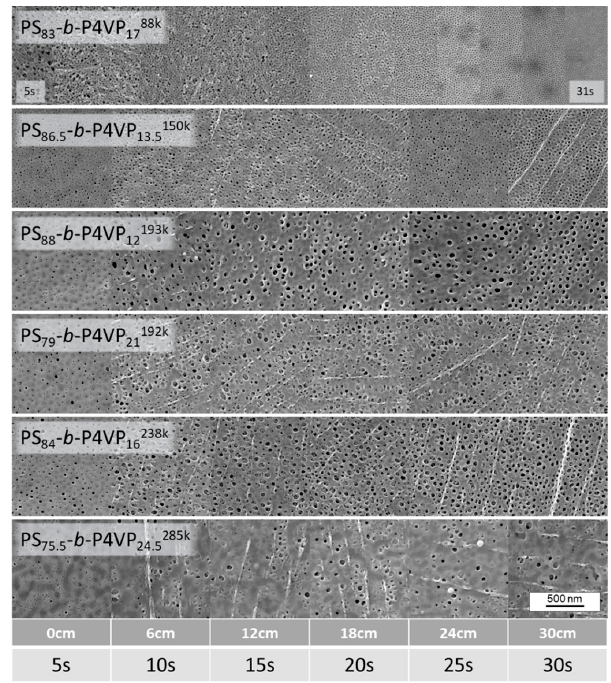
Figure 4. Gradient samples of different PS- b -P4VP membranes with a changing evaporation time along the sample. The casting speed was 8.2 cm/s and after 41 cm the velocity was reduced to 1.2 cm/s after application of the BCP-film. The left side (0 cm; 5 s) first met the precipitation bath. With this method, the changing pore morphology with ongoing evaporation was investigated in single samples to ensure constancy of all other influencing parameters like fluctuating fume hood strength, humidity or concentration deviations of the casting solutions.